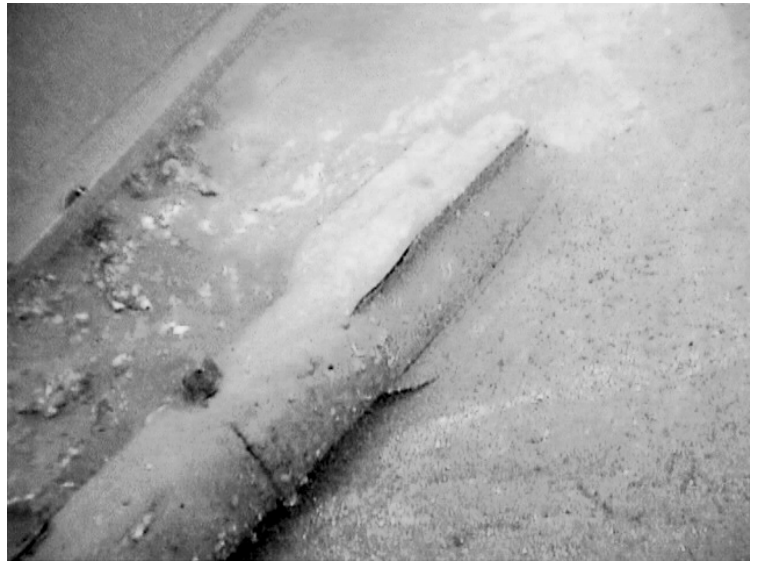
Figure 12. Anomaly number 13 found at a depth of 17 m buried under 1m of sand. The artifact is a dud of aircraft flare from the 60-70's.